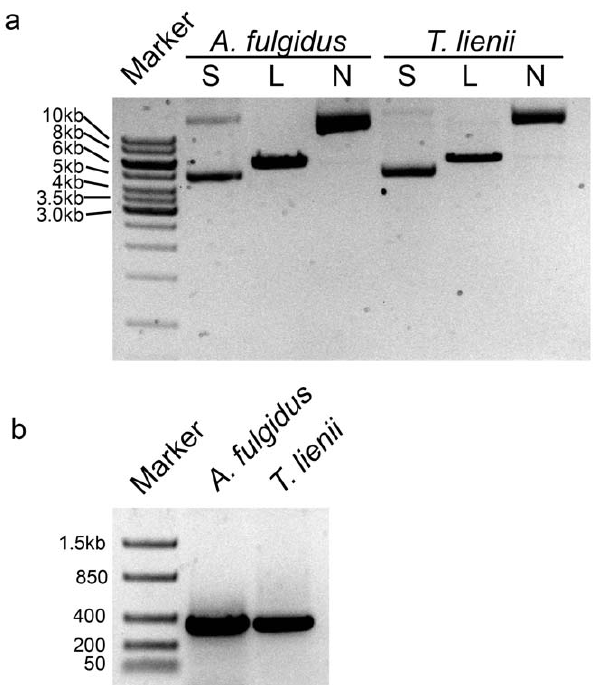
Figure 1. Preparation of 16S rRNA gene standards. Representa- tive archaeal ( A. fulgidus ) and bacterial ( T. lienii ) ( a ) plasmids: Marker=1 kb DNA ladder, S=freshly isolated supercoiled plasmid, L=linearized plasmid ( SpeI -digested), and N=nicked circular plasmid ( Nb.BtsI -digested) and ( b ) PCR amplicons: Marker=low range DNA